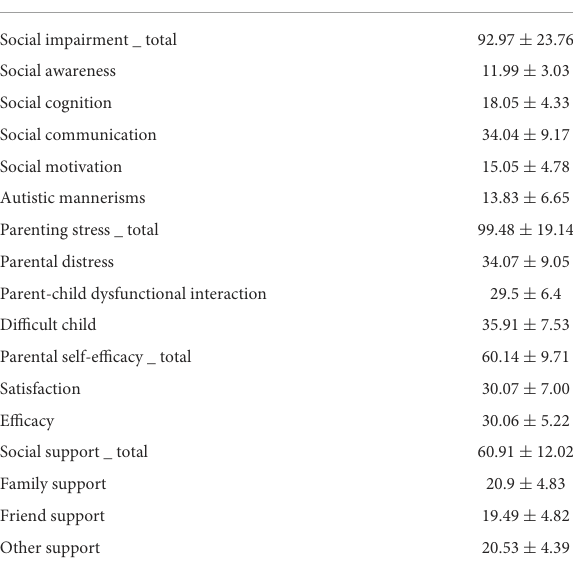
TABLE 2 Mean scores for variables of interest ( N =